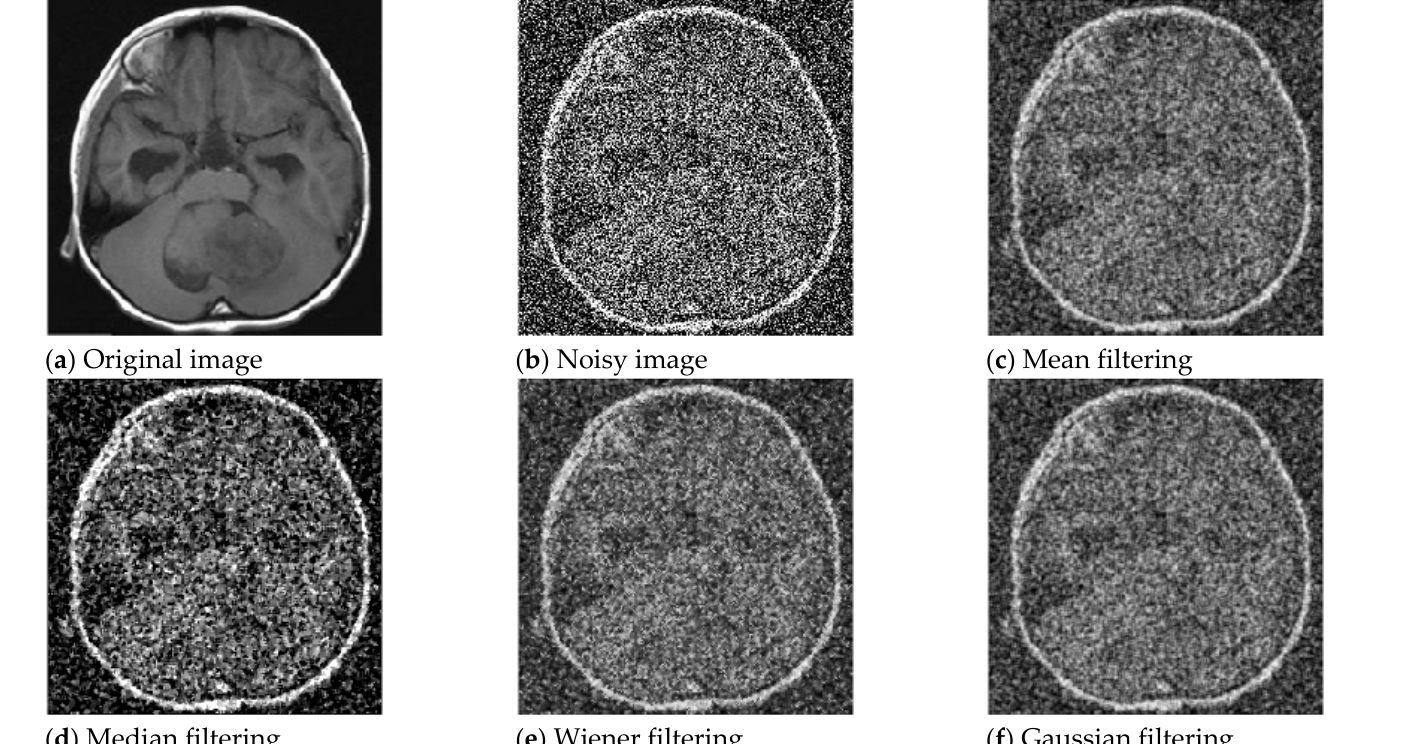
Figure 8. MRI image enhancement for four classical filtering methods. Table 5. MRI image under four classical filtering algorithms for PSNR (dB).